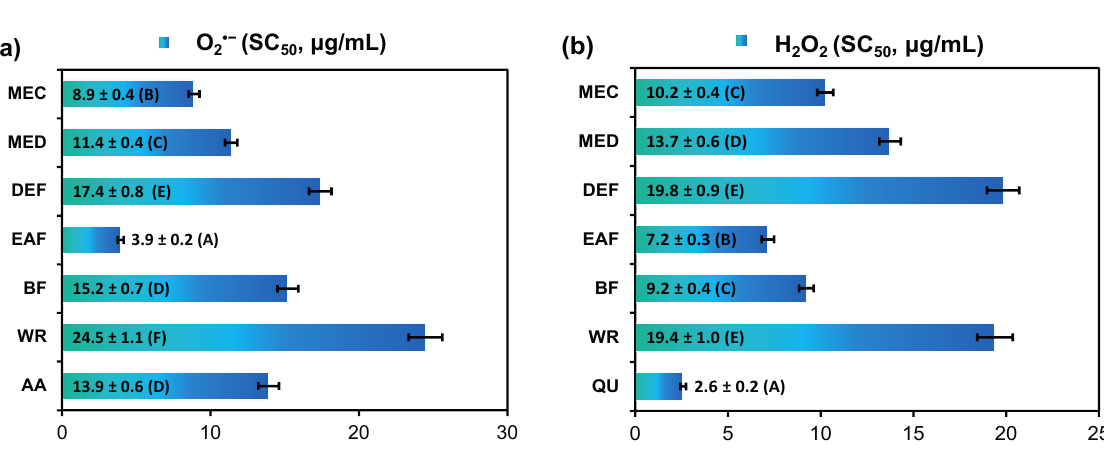
Figure 2. Radical-scavenging activity of G. procumbens dry leaf extracts towards: ( a ) superoxide anion (O 2• − ) and ( b ) hydrogen peroxide (H 2 O 2 ).